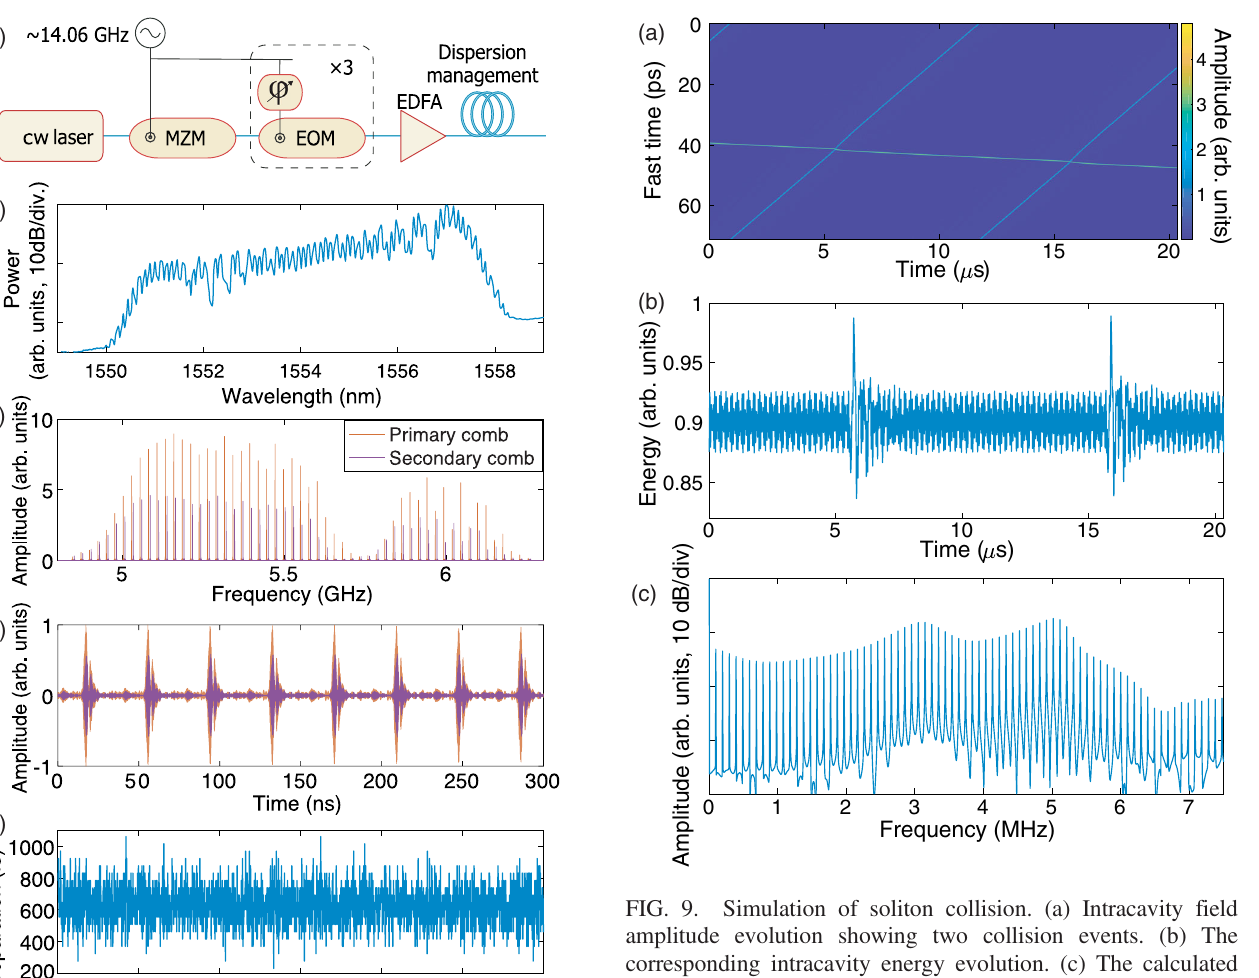
order μ ¼ 47 is the same as that in the experiment shown in Fig. 4. The primary pump-resonance detuning ( 2 πδ ) is set to be 70 κ , and the dual-pumping detuning mismatch ( j Ω j ) is 50 κ . The second-order dispersion coefficient ð D 2 kHz and third-order dispersion coefficient ð D − 1 Hz are included in the resonator dispersion. A single primary DKS and a single secondary DKS are seeded, and the whole simulation includes 2 . 1 × 10 6 round-trip times. Figures 9(a) and 9(b) show two collision events in the intracavity field evolution and the corresponding